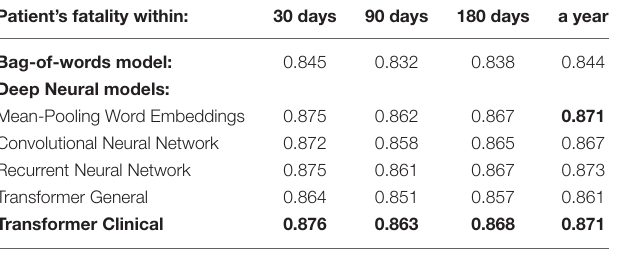
TABLE 4 | The overall performance of the models on the entire discharge summaries for the patient fatality prediction targets. Patient’s fatality within: